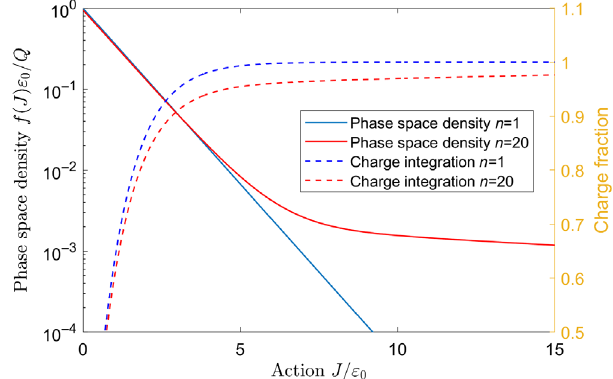
FIG. 2. Phase space density and charge integration along the action axis according to Eq.